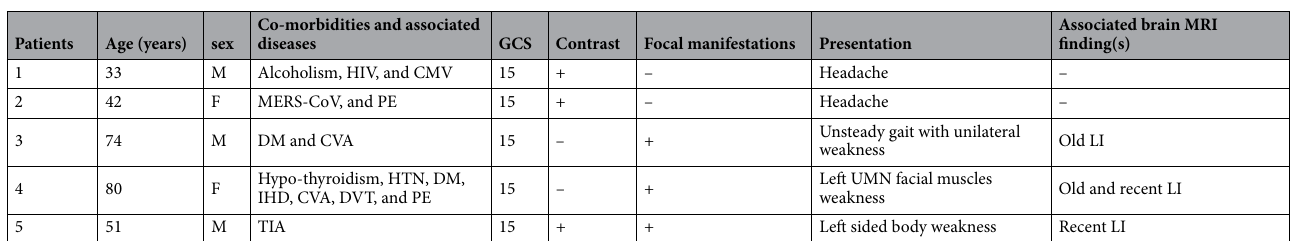
Table 4. Characteristics of five admitted patients with SARS-CoV-2 pneumonia, whose brain MRI showed bilateral subcortical white matter focal lesions hypointense on T 1 WI and hyperintense on T 2 WI and